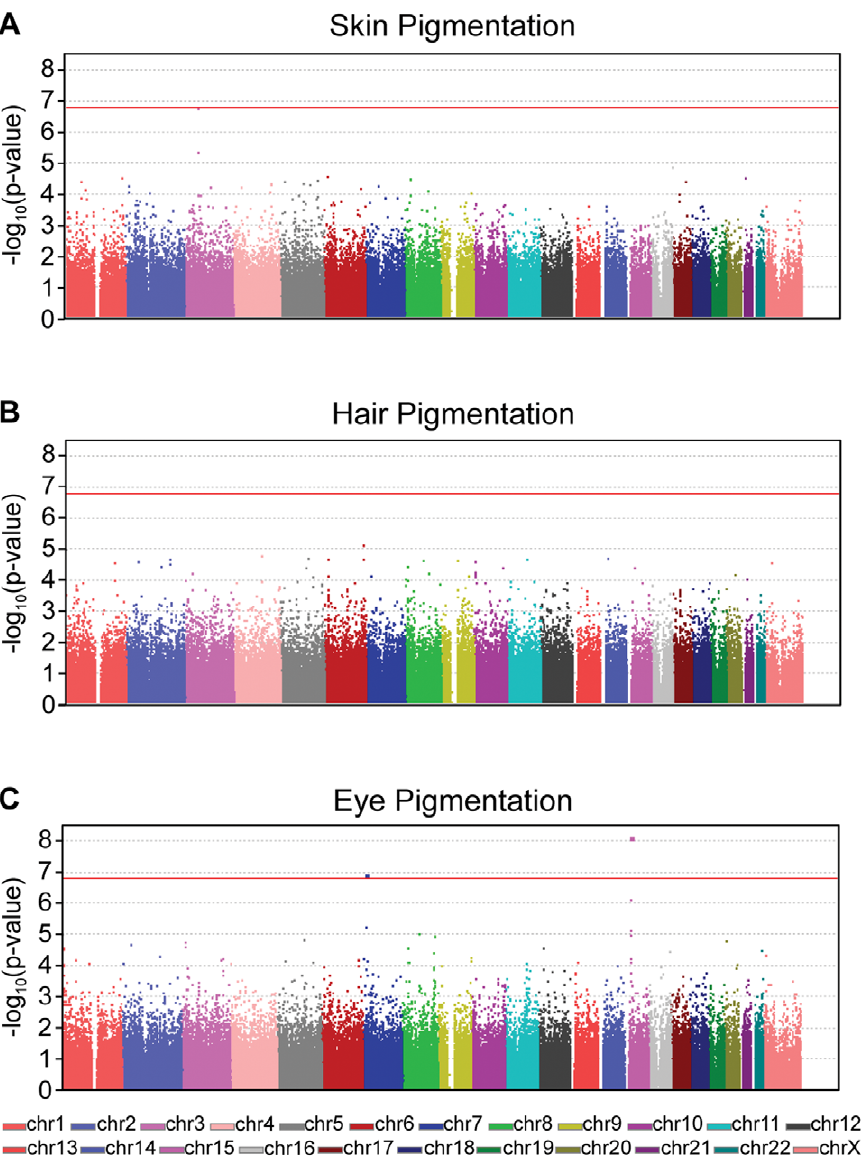
Figure 5. GWAS results. Manhattan plots for the GWAS results for the skin ( A ), hair ( B ), and eye ( C ) pigmentation. The log-transformed p-values from the test of association are plotted as a function of the chromosomal position. Genome-wide significance is defined as the Bonferroni corrected 5% significance threshold (p-value , 1.6 6 10 2 7 ) and is indicated as a red line. For skin pigmentation, one SNP on chromosome 3 in the FLNB gene almost reaches genome-wide significance (p-value=1.8 6 10 2 7 ). No SNP achieves genome-wide significance in the hair pigmentation GWAS. For eye pigmentation, two SNPs, one near the pigmentation gene OCA2 on chromosome 15 and one in the SCIN gene on chromosome 7 achieve genome- wide